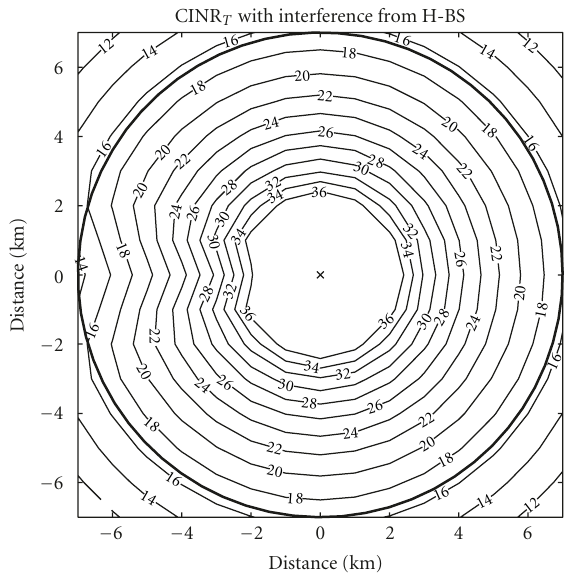
Figure 3: CINR H performance contour plot of HAP (marked as “o”) coverage area.